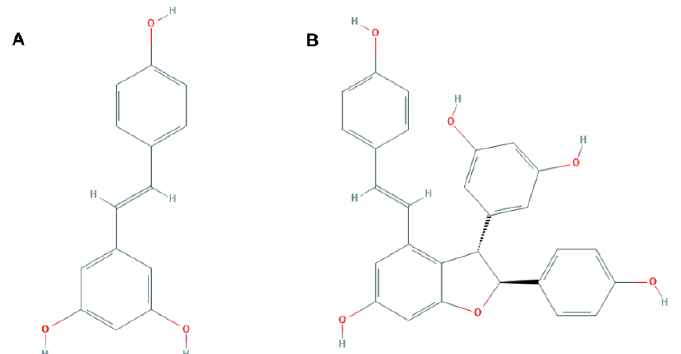
Figure 1. The chemical structures of trans-resveratrol (CID: 445154) ( A ) and trans- ε -viniferin (CDI: 5281728) ( B ).